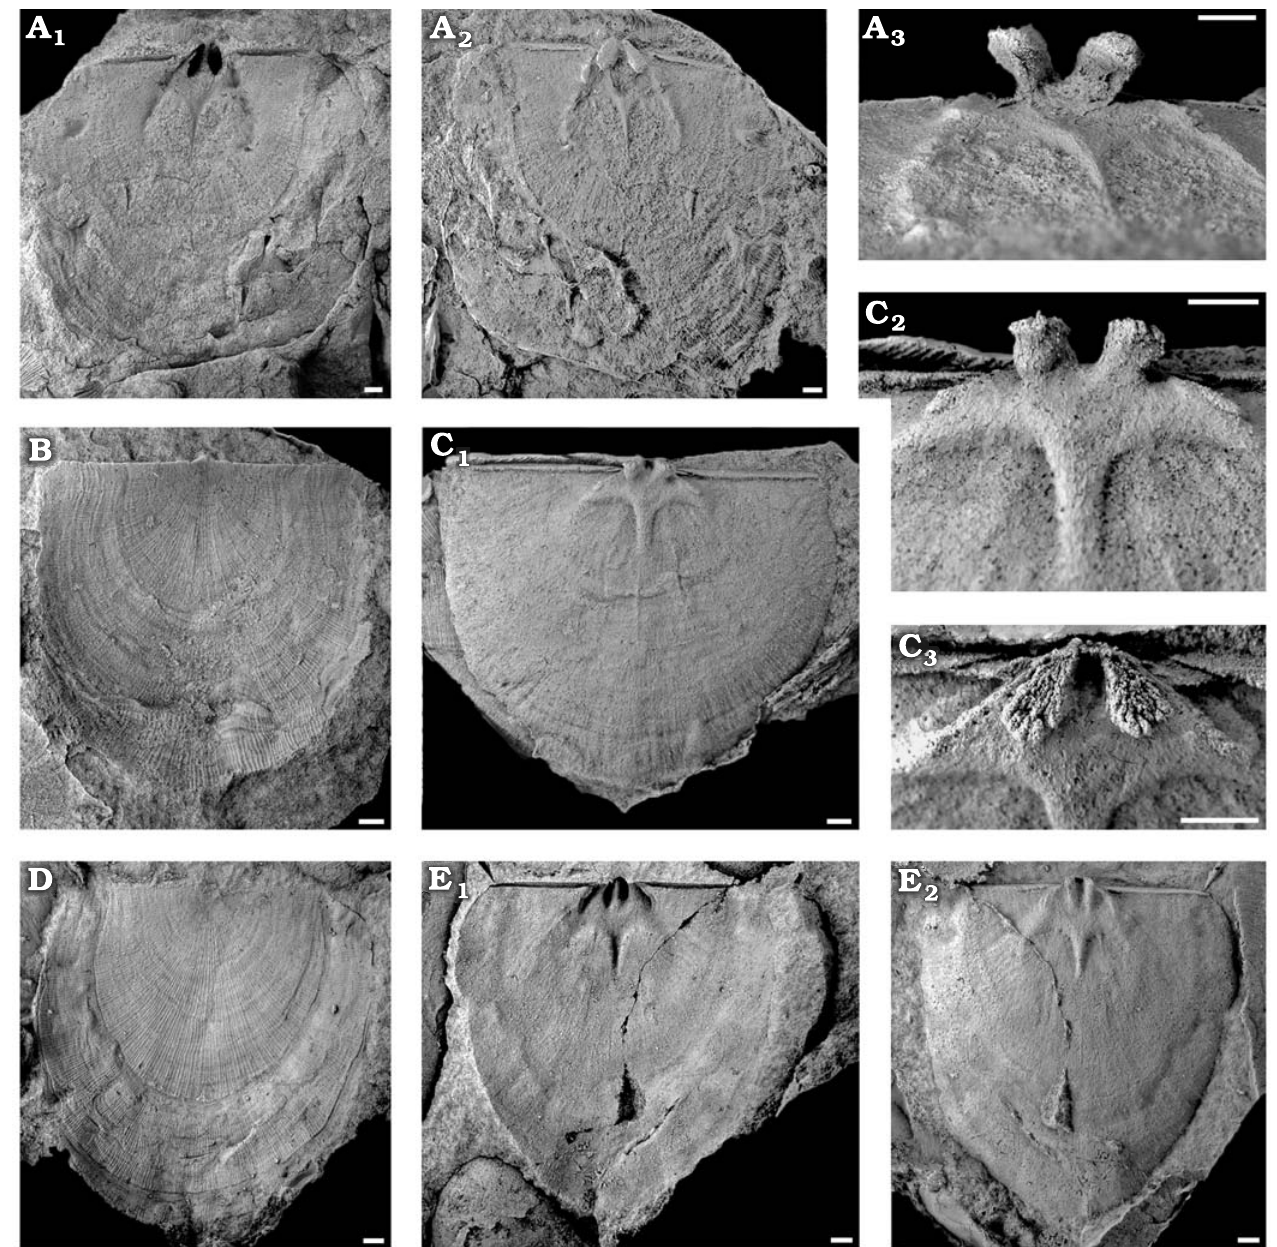
Fig. 16. Dorsal valves of rafinesquinine brachiopod Rafinesquina ( Mesogeina ) pomoides Havlí č ek, 1971; middle Katian (Ka2), Upper Ordovician; Lower Ktaoua Formation, Morocco (A, B); Huerva Member of Fombuena Formation, Iberian Chains, Spain (C–E). A . MPZ_2003_833, internal mould (A 1 ) and latex cast of interior (A 2 ), detail of cardinalia in anteroventral view (A 3 ). B . MPZ_2003_843, latex cast of exterior. C . DPZ-356, latex cast of interior of a dorsal valve (C 1 ), detail of cardinalia in anteroventral (C 2 ) and posteroventral (C 3 ) views. D . DPZ-354b, latex cast of exterior. E . DPZ-354b’, internal mould (E 1 ) and latex cast of interior (E 2 ). Scale bars 2 ( Mesogeina ) pomoides , although the dorsal valves of the Portuguese shells remain unknown.